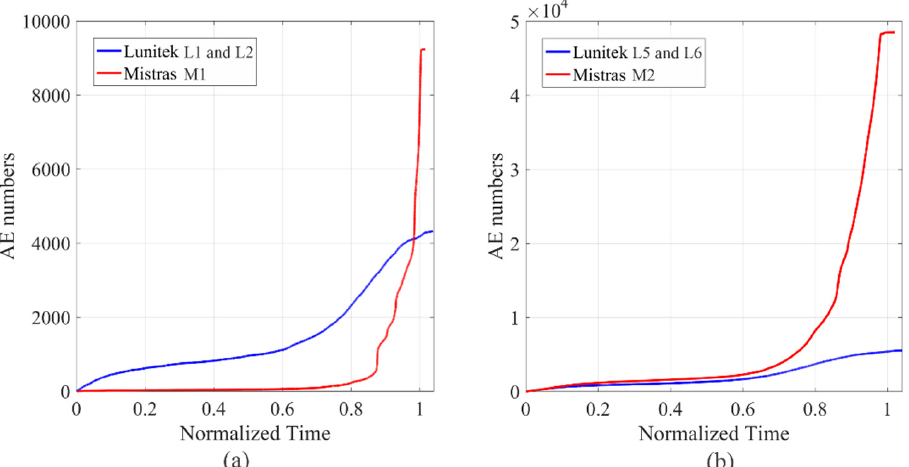
Figure 10. Partial counts related to: ( a ) frontal face of the cube (Lunitek sensors L1 and L2, Mistras sensor M1) and; ( b ) back face of the cube (Lunitek sensors L5 and L6, Mistras sensor M2) (see Fig- ure 4b). Figure